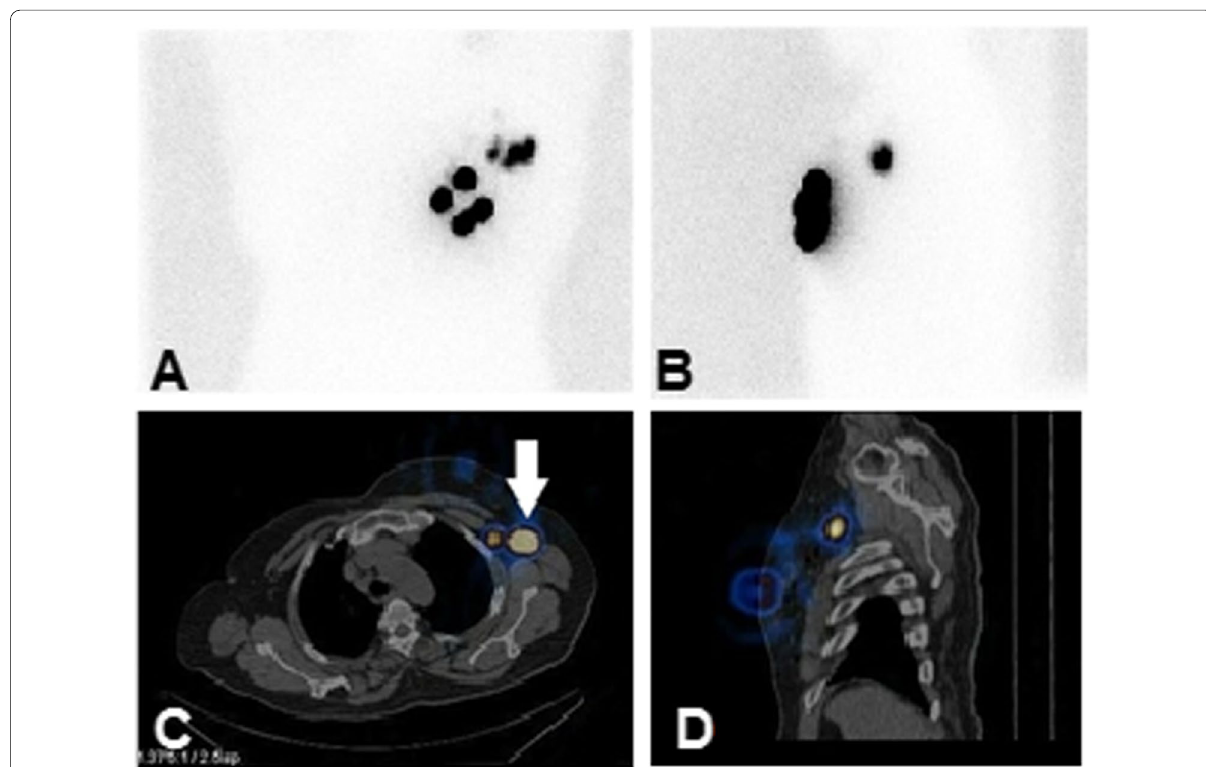
Fig. 2 36-year-old female with invasive ductal carcinoma of the left breast. A , B PS demonstrates multiple foci of activity in the left axilla, two of which along the midclavicular line. C , D Hybrid cross-sectional SPECT/CT images demonstrate the foci of activity lateral to the pectoralis minor station at Level-I. The lateral focus shows three small matted axillary nodes